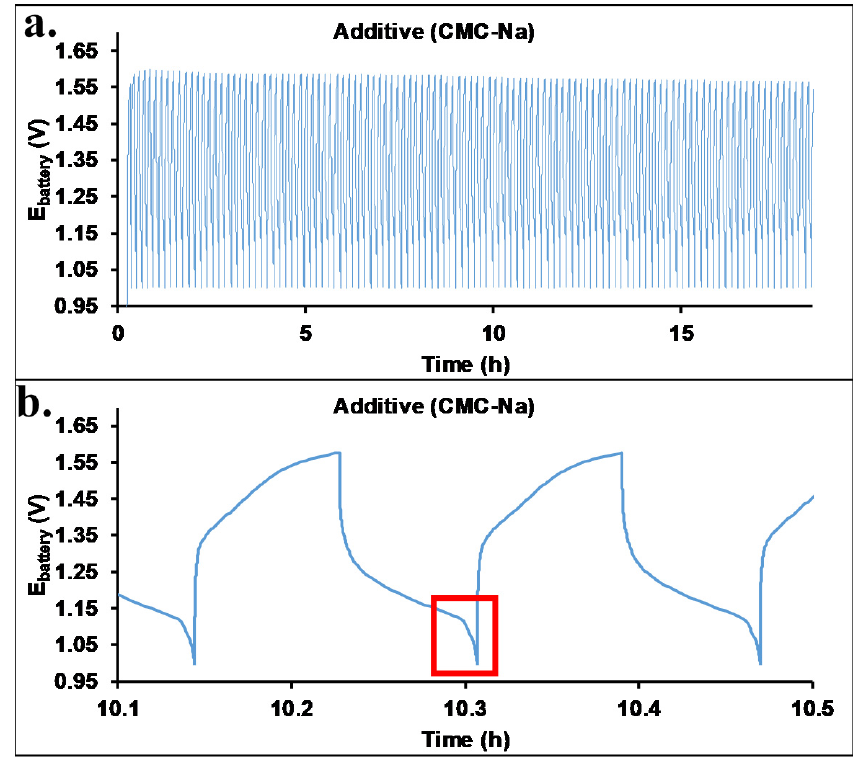
Figure 4. The cyclic performance test ( a ) of the Zn-air battery filled with an electrolyte containing 2 m/v% CMC-Na salt. The lower figure ( b ) shows the zoomed charging/discharging cycles (the sharp decreasing in the cell potential is highlighted by red